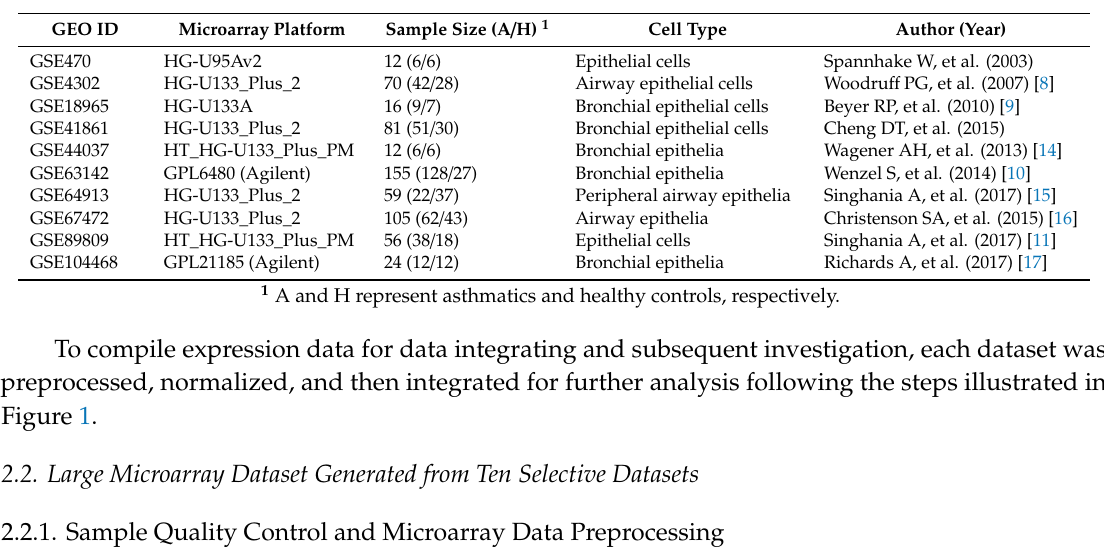
Table 1. Information summary of microarray datasets used in this